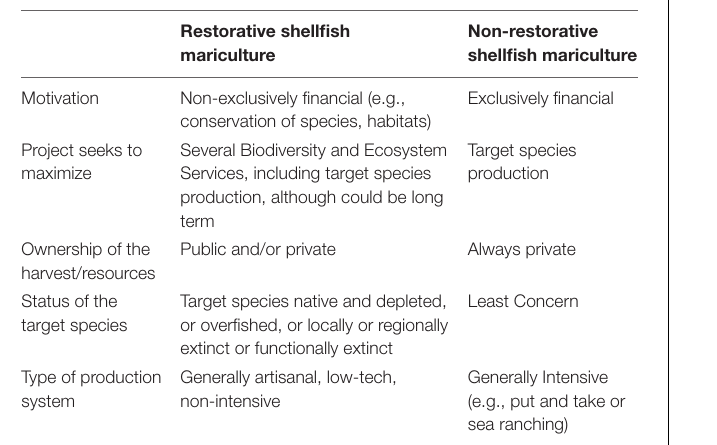
TABLE 1 | List of the criteria involved in the definition of Restorative Shellfish Mariculture, contrasted to “pure” or “commercial” mariculture.